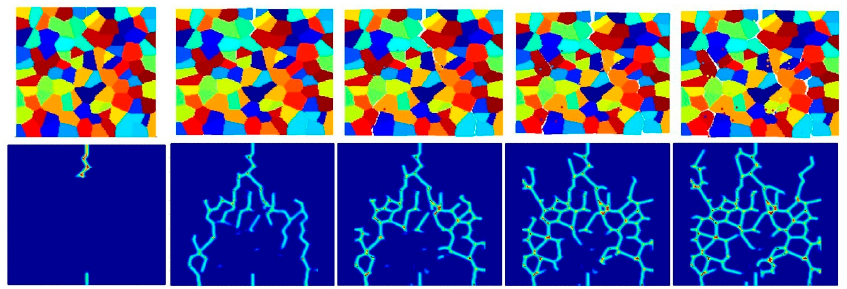
Figure 24. Fracture pattern of polycrystal when β = 0.5 with 100 grains in total. From left to right: time = 1.5 μ s, 2.0 μ s, 2.5 μ s, 3.0 μ s, and 3.5 μ s, respectively.